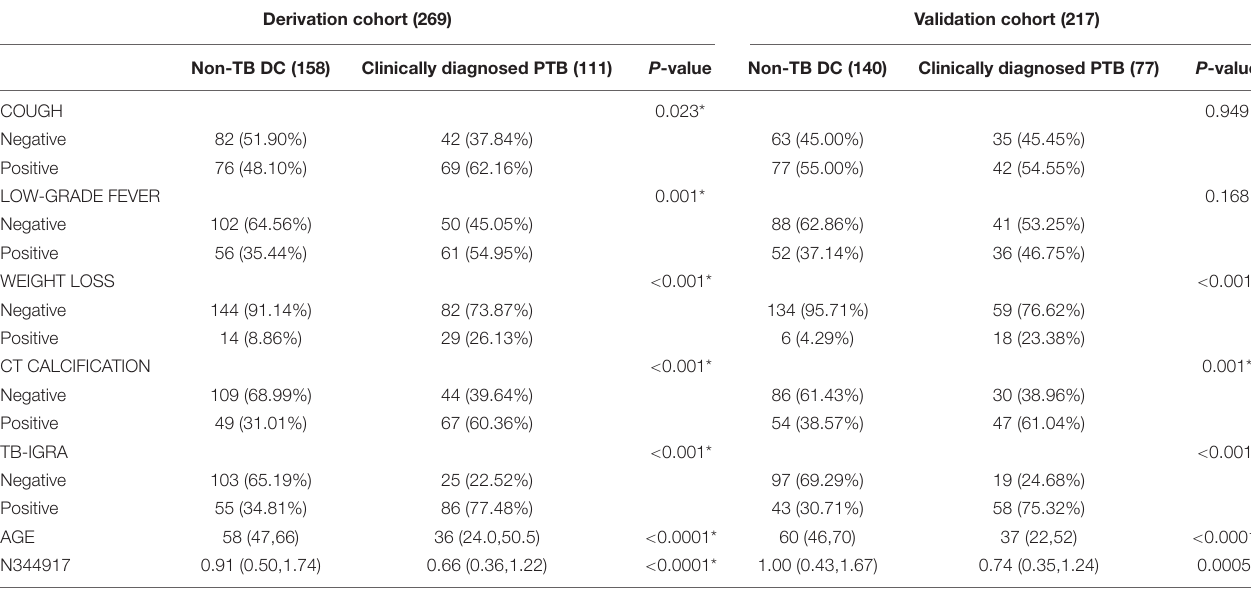
TABLE 1 | Indicators in the web